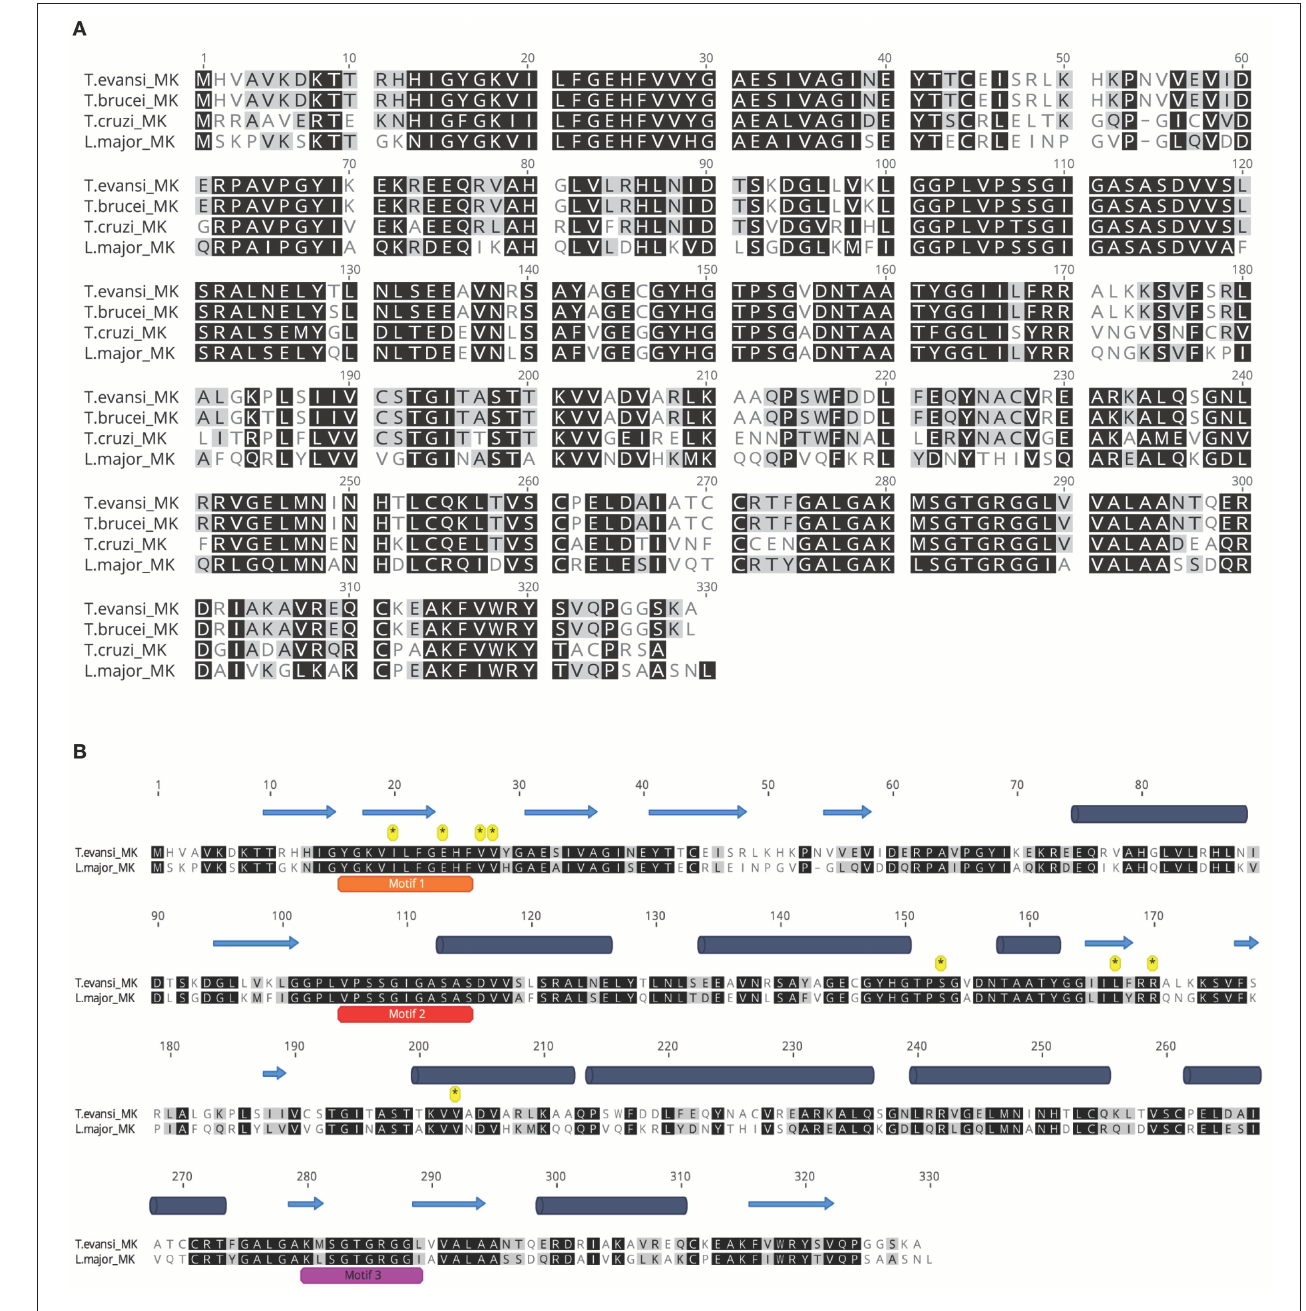
FIGURE 1 | TeMVK is highly similar to MVKs from other trypanosomes. (A) Sequence alignment of MVKs from four related species. TeMVK gene was cloned and sequenced, and the protein sequence aligned to TbMVK (Q581L1, UniProt), TcMVK (Q4DJT8), and LmMVK (Q4Q6K7). Identical and similar residues are shown in black and gray, respectively. (B) Ab initio secondary structure prediction using Jpred4. TeMVK was aligned with LmMVK. Three conserved motifs 1, 2, and 3 (orange, red, and magenta bars) and residues known to bind mevalonate (asterisks) in LmMVK are indicated. Cylinders, α -helices; Arrows, β -sheet strands.